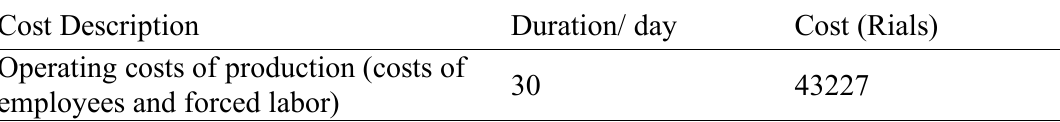
Table 8. Amount of cash required, except for the cost of